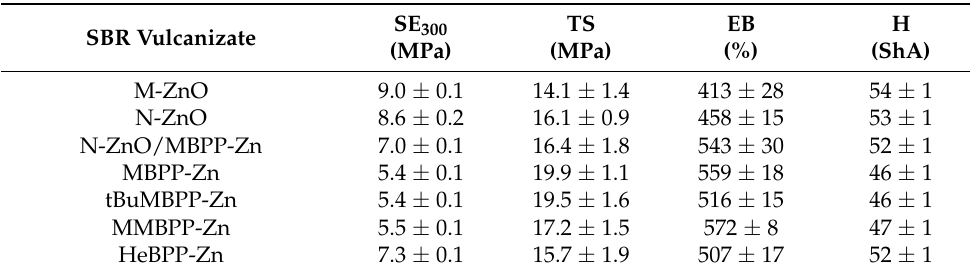
Table 5. Tensile properties and hardness of SBR compounds containing ZnO and zinc complexes with 1,3-diketones as